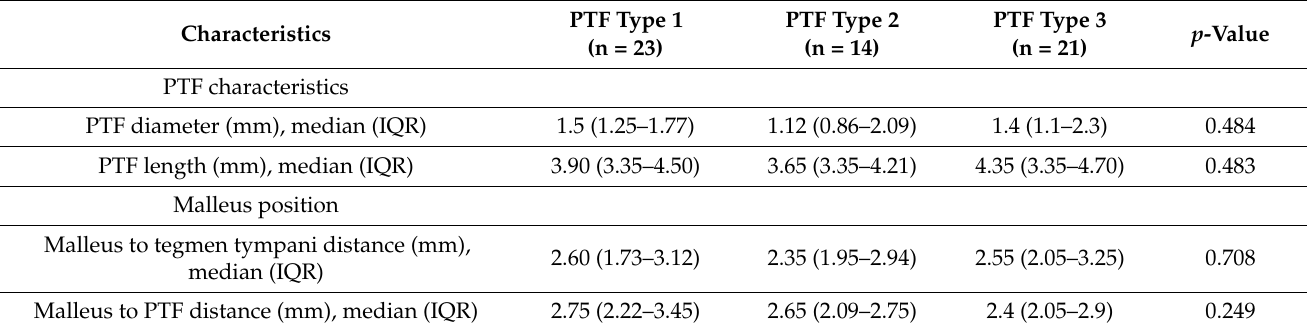
Table 2. CBCT evaluation of PTF characteristics and malleus position.